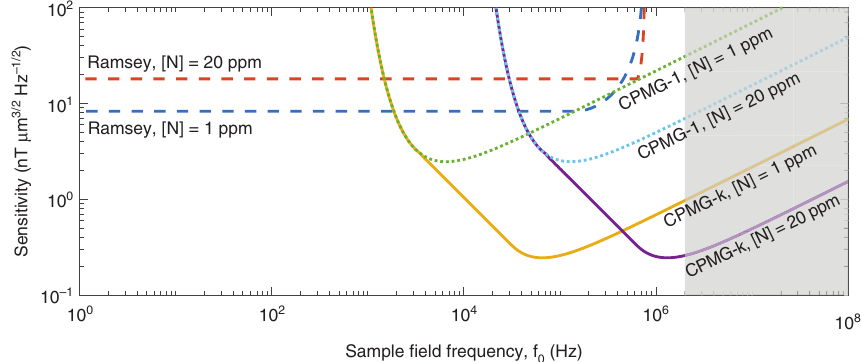
Figure 11: Frequency dependence of QDM volume-normalized sensitivity. Achievable volume-normalized magnetic field sensitivity as a function of the sample field frequency for DC broadband and AC narrowband